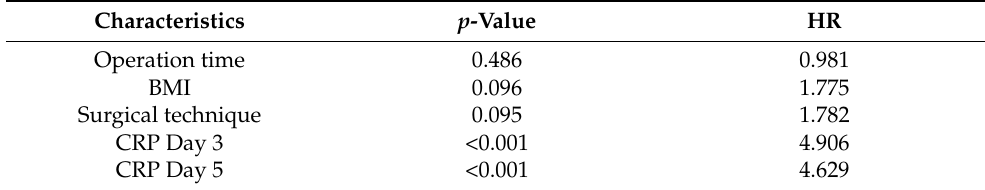
Table 2. Multivariate analysis for length of hospital stay (LOS).